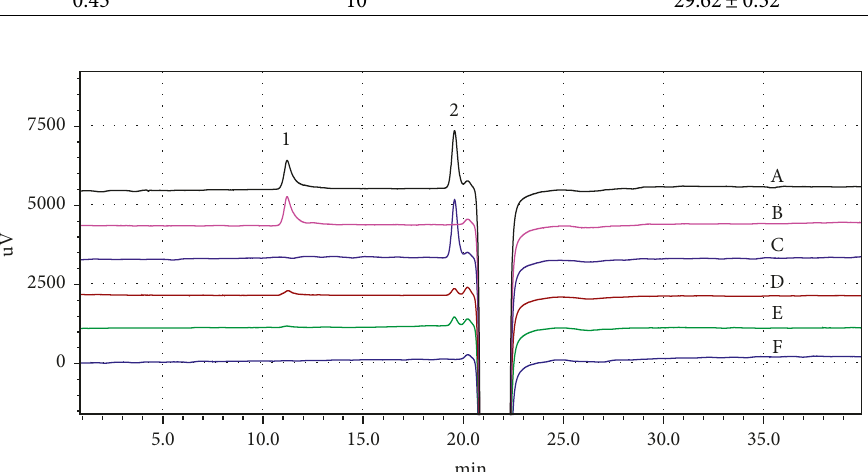
Figure 1: Chromatograms for specificity of the proposed analytical method. (a) Mixing solution of PVA (50 μ g/ml) and mannitol (50 μ g/ ml), where 1 was peak of PVA and 2 was peak of mannitol. (b) PVA standard solution (50 μ g/ml). (c) Mannitol solution (50 μ g/ml). (d) Sample solution of aripiprazole-loaded PLGA microspheres with PVA concentration of about 2.6 μ g/ml. (e) Sample solution of placebo without PVA. (f) Blank solution.